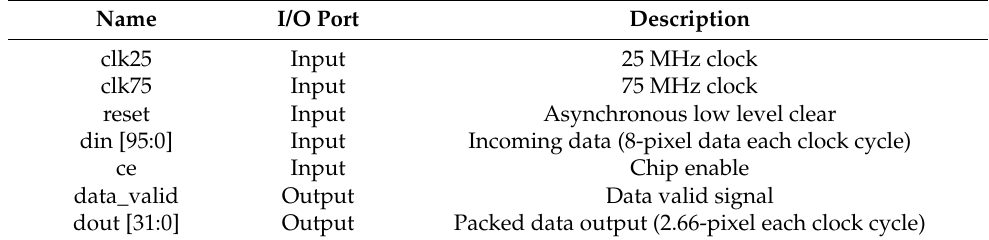
Figure 12. Interface of the implemented packer.vhd module. Table 5. Port description of the swapping